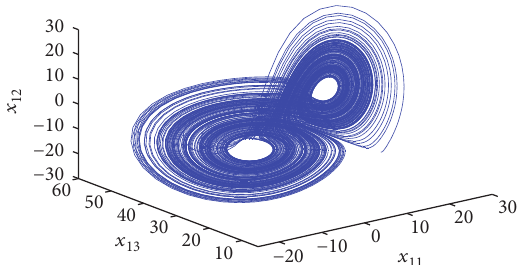
Figure 1: The chaotic behavior of time-delayed Lorenz system.